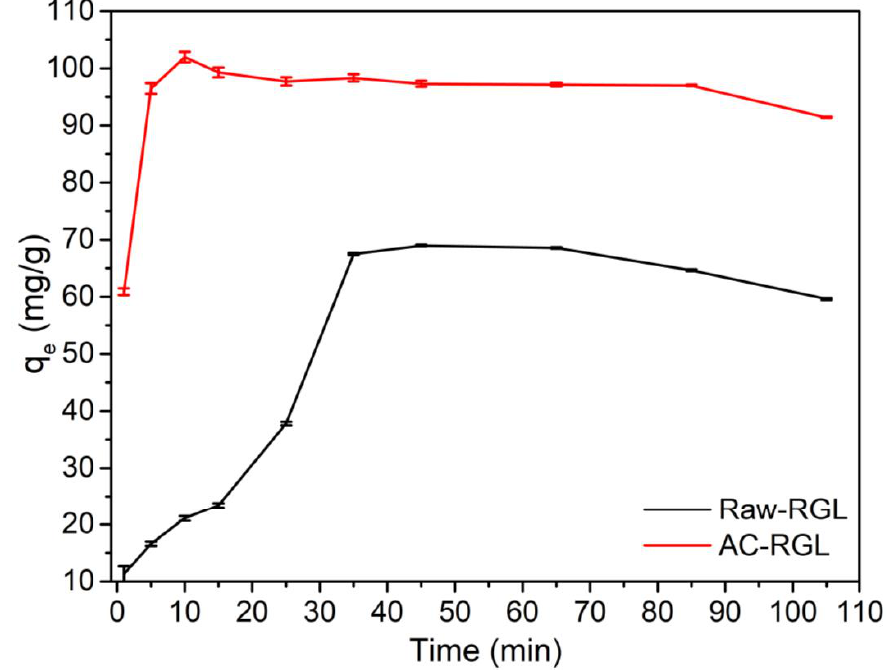
Figure 7. Effect of time on ibuprofen uptake by Raw-RGL and AC-RGL adsorbents. The kinetic data of ibuprofen adsorption by Raw-RGL and AC-RGL were fitted into the pseudo-first-order (PFO), pseudo-second-order (PSO) models and intraparticle diffu- sion (IPD) and the data are shown in Table 5. This was done to estimate whether the ad- sorption process fit the PFO, PSO, or IPD models. The best-fit model must have a correla- tion coefficient close to 1. Table 4 shows that PFO was the best fit with r 2 of 0.995 and 0.993 for Raw-RGL and AC-RGL, respectively. The best fit for PFO shows that the uptake of ibuprofen by Raw-RGL and AC-RGL involves Van der Waal forces of attraction and that process was physisorption [56]. IPD kinetic estimation shows whether adsorption oc- curred in the pores or the surface. Table 4 shows that the estimated surface adsorption (ESA) was the main process compared with the estimated pore adsorption (EPA). ESA is